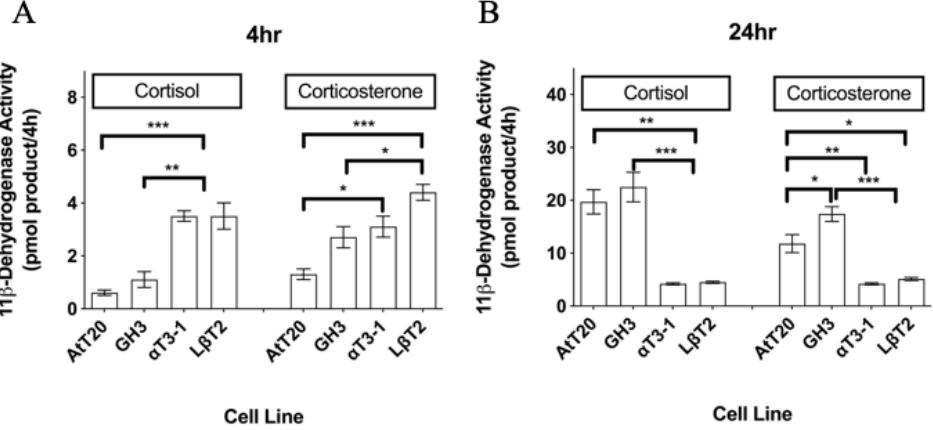
Figure 1. 11 β -dehydrogenase activities in four pituitary cell lines measured over ( A ) 4 h or ( B ) 24 h using 100 nM [ 3 H]-cortisol and 100 nM [ 3 H]-corticosterone as enzyme substrates. Data shown are mean ± SEM for three different cell passages pooled together (n = 3) (with triplicate measures in each passage). For a given time point and substrate, mean values with different superscripts differ significantly ( p < 0.05) (one-way ANOVA with the Tukey–Kramer multiple comparison as the post hoc test).